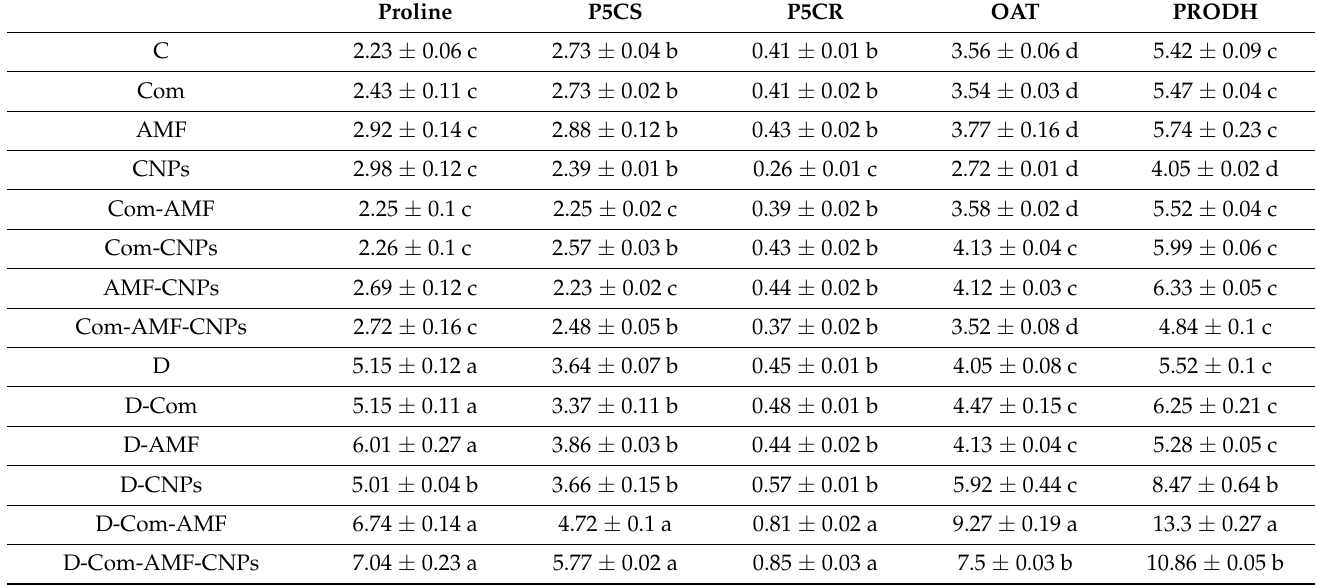
Table 4. Effect of different treatment proline metabolic enzymes of maize under control and drought (D) conditions. Different letters indicate statistically significant difference between means for the different treatments at significance level of at least p ≤